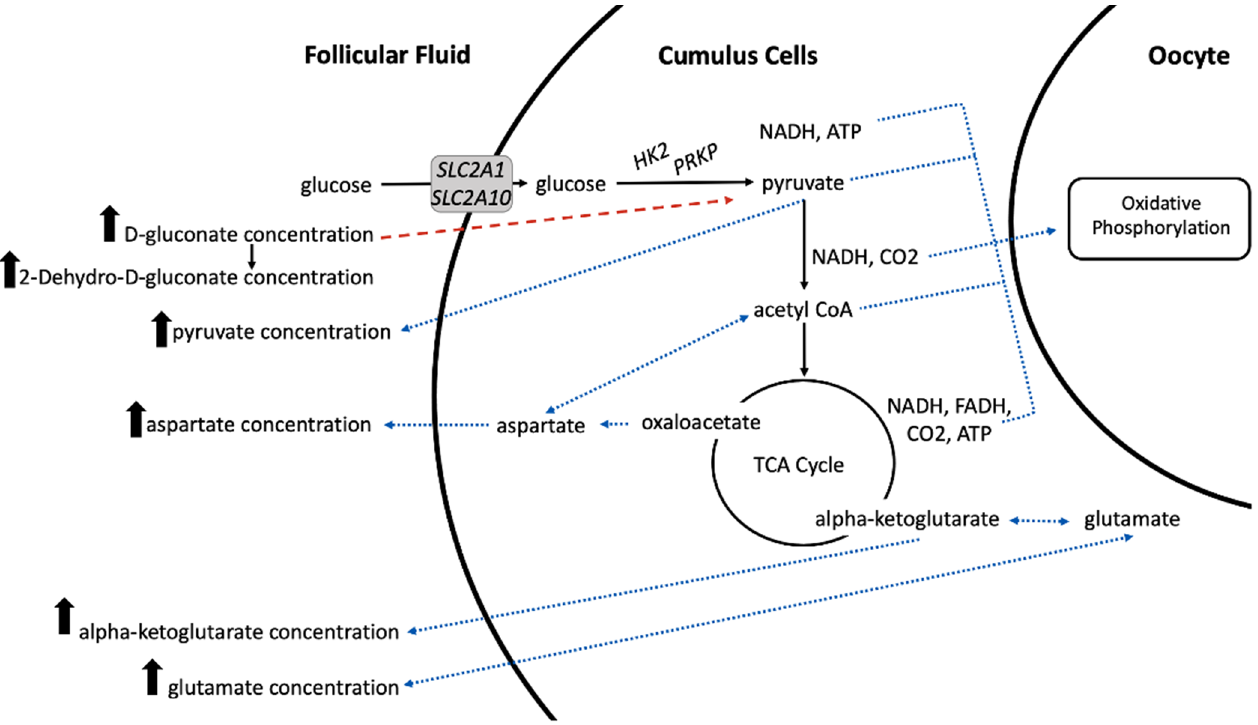
Figure 4. Proposed model of altered glucose metabolism in cumulus cells of small pre-ovulatory follicles. Increased concentration of pyruvate, aspartate, alpha-ketoglutarate, and d-glutamate in the follicular fluid of larger pre-ovulatory follicles is likely the result of increased glucose consumption by the cumulus cells and more efficient glucose, pyruvate, and tricarboxylic acid (TCA) cycle metabolism in the cumulus cells of larger follicles (represented by solid black arrows). Our previous results of increased transcript abundance for glucose transporters ( SLC2A1, SLC2A10 ) and glycolytic enzymes ( HK2, PRKP ) in cumulus cells of large versus small pre-ovulatory follicles support the proposed model. Increased production of pyruvate and downstream metabolic products allows increased metabolite abundances to be transferred back into the follicular fluid and to the oocyte to support energy production needed for oocyte maturation, fertilization, cleavage, and early embryo development (represented by blue dotted arrows). Increased concentration of d-gluconate and its downstream product 2-Dehydro-D-gluconate in the follicular fluid of larger follicles is likely due to reduced import of D-gluconate into the cumulus cells (represented by a dashed red arrow) because of preferential import of glucose.